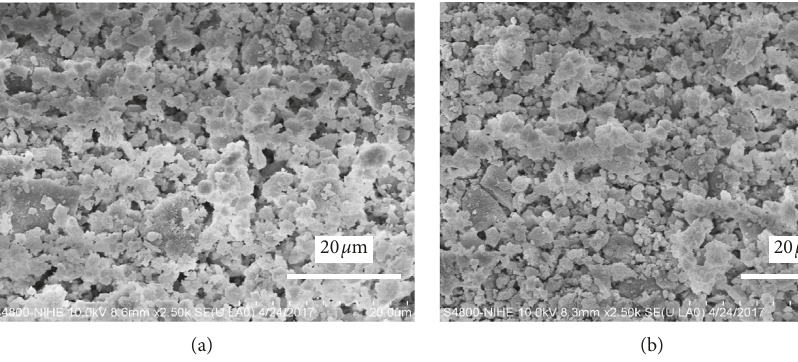
Figure 6: SEM images of H 3 granules sintered at (a) 600 ° C and (b) 700 ° C.